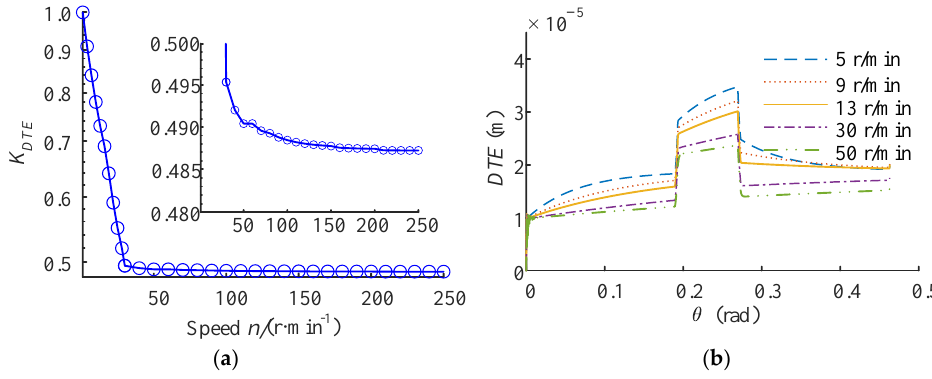
Figure 8. Dynamic response of epoxy gear pair: ( a ) K v ; ( b )